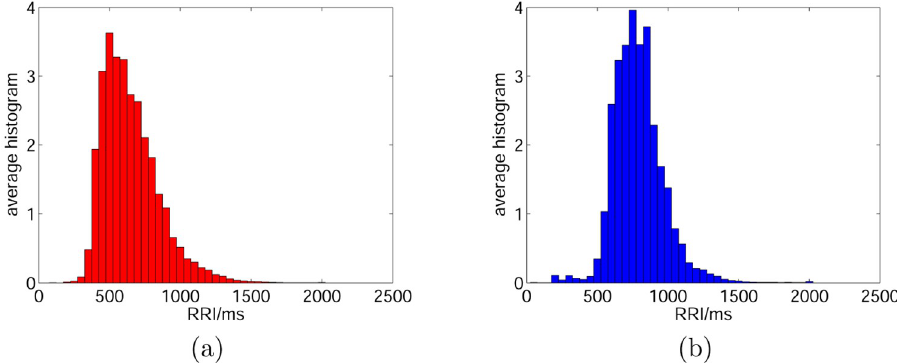
Fig 2. The average histogram of RRIs. (a) represents AF records of AFDB, and (b) represents normal records from